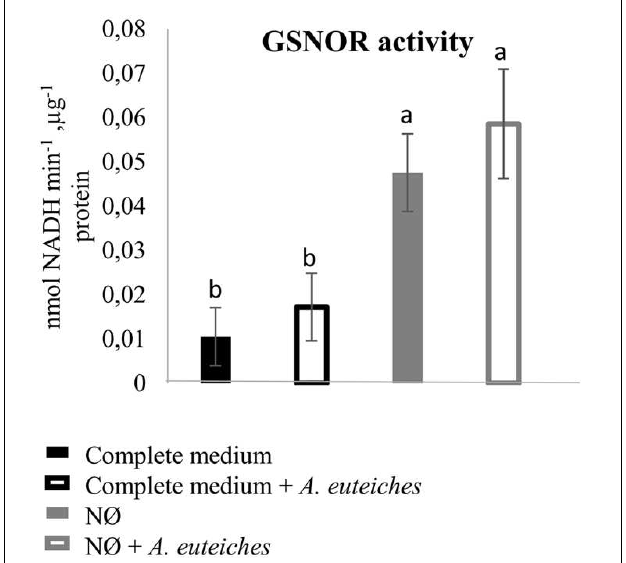
FIGURE 5 | GSNO reductase activity in M. truncatula roots 7 dpi. M. truncatula seedlings were inoculated or not with A. euteiches, and cultivated on complete medium or NØ medium for 7 days. Root extracts were used to measure GSNOR activity. Error bars indicate standard errors ( n = 4), and letters indicate significant differences ( p < 0.05). Data from one representative experiment out of four independent experiments.